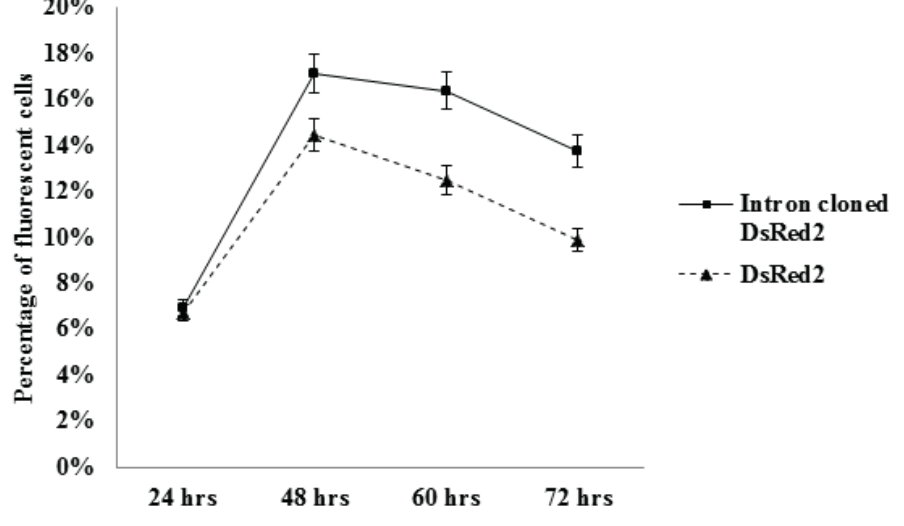
Fig. 4. Comparative analysis of number of cells expressing red fluorescence when transfected with native DsRed2 gene and intron cloned DsRed2